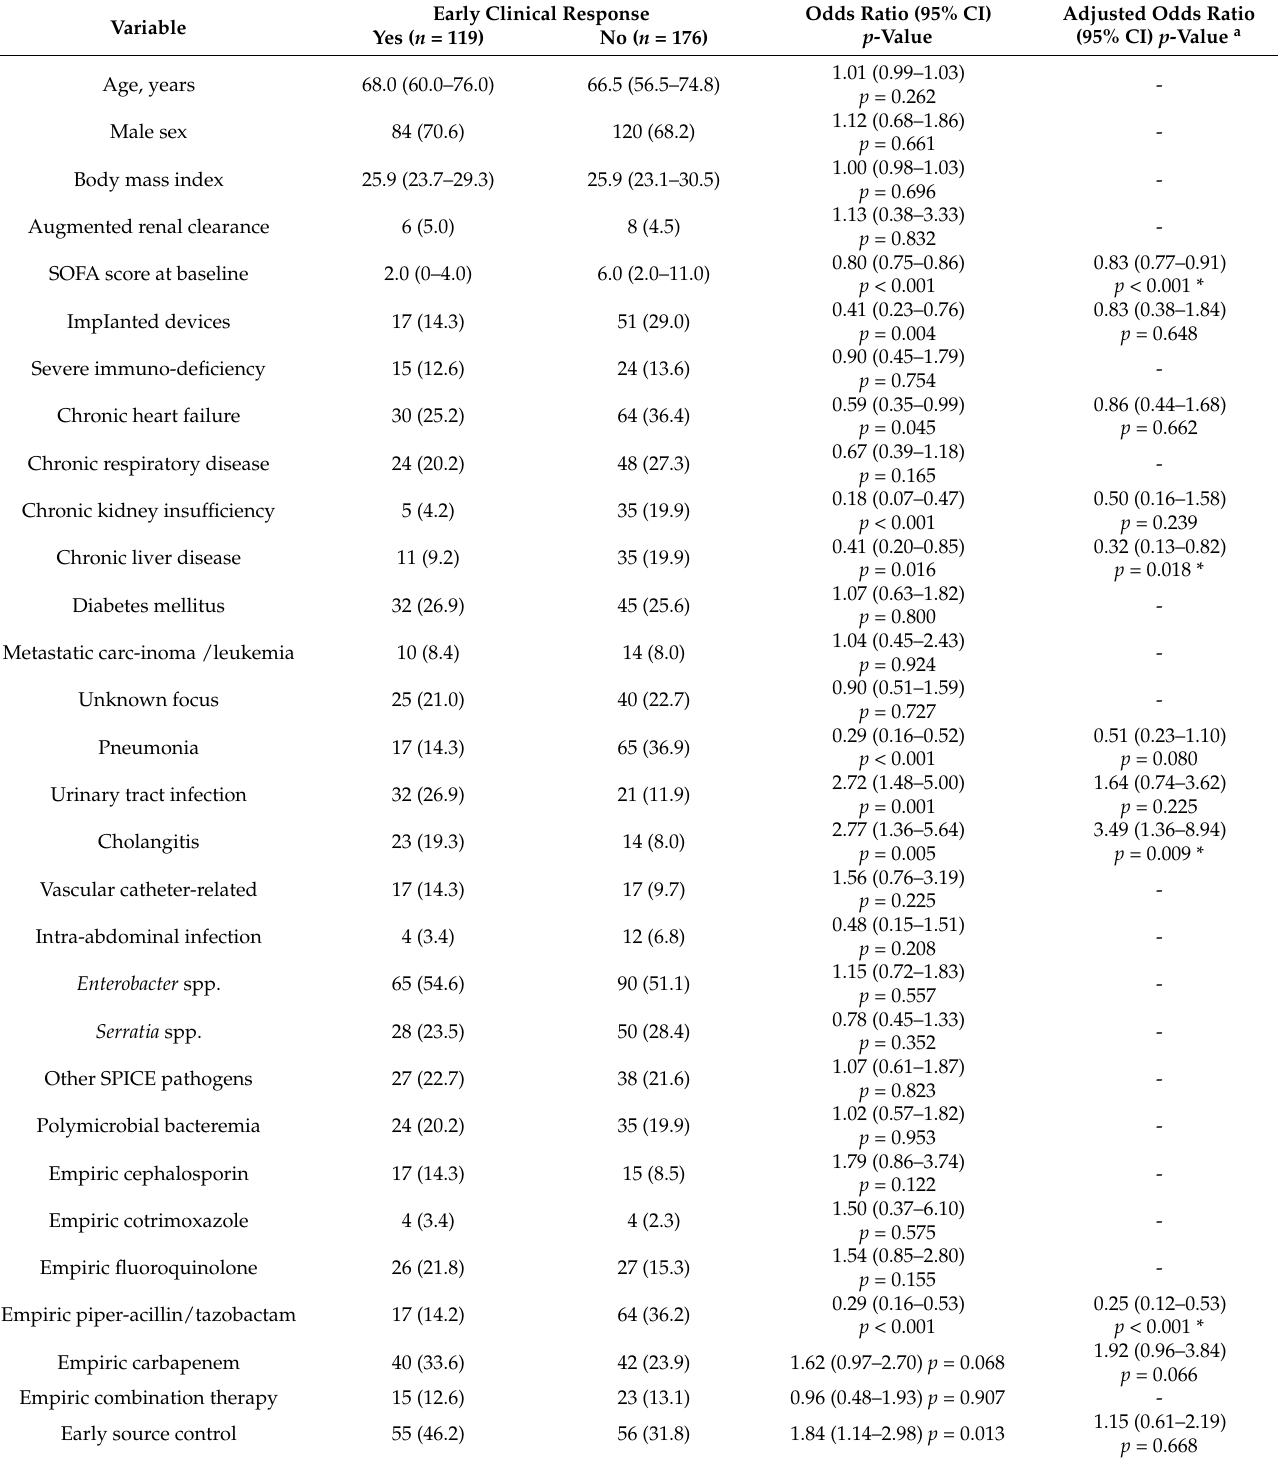
Table 3. Predictors of early treatment response in patients with SPICE